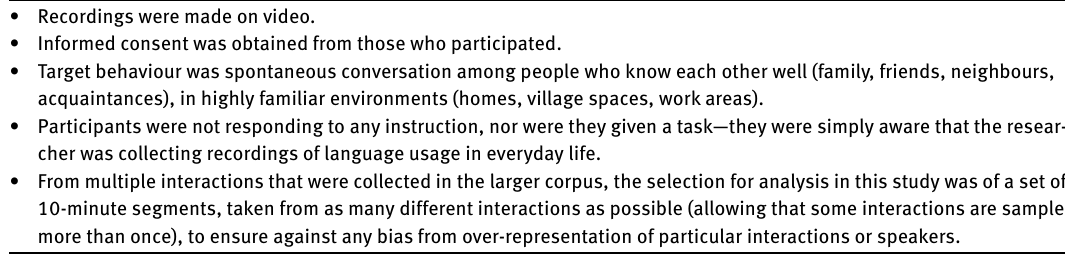
Table 1: Key properties of the data collected for this